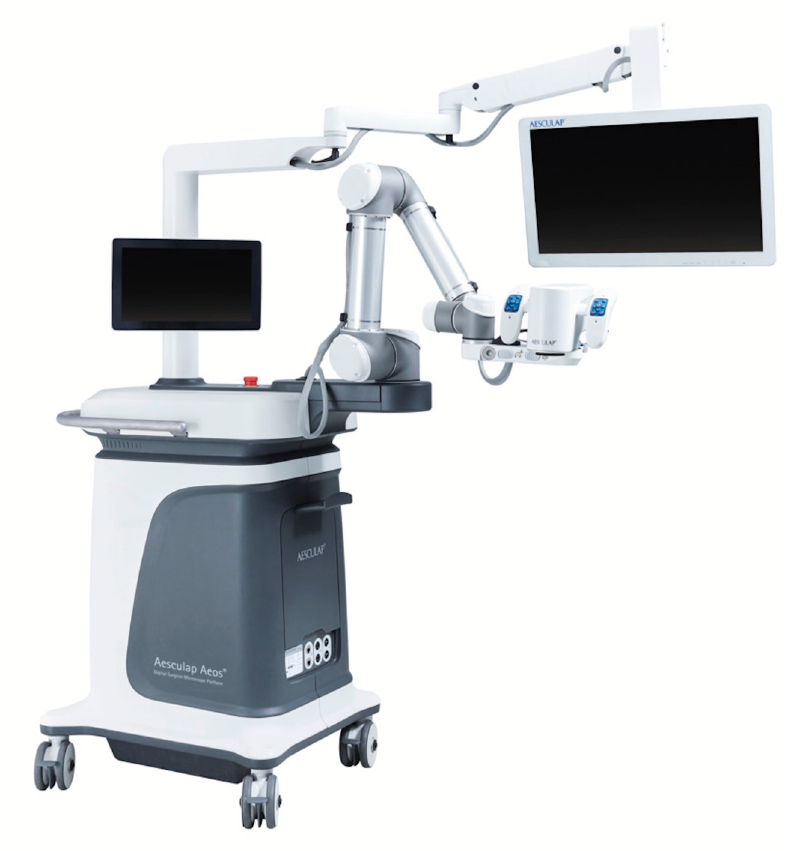
Figure 2. The Aesculap Aeos Three-Dimensional Robotic Digital Microscope.